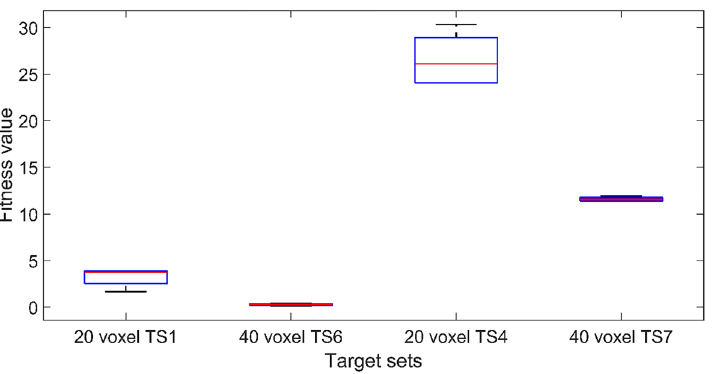
Figure 8. The effects of voxel number on the fitness value. The solid lines in the middle indicate the median fitness value, and the boxes represent the 25th and 75th percentiles.